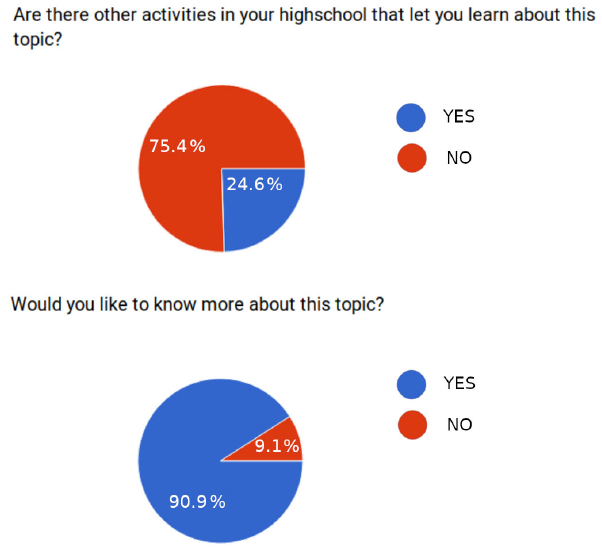
Figure 8. Results of two relevant questions related to the interest of students about the laboratory practice and aroused interest.